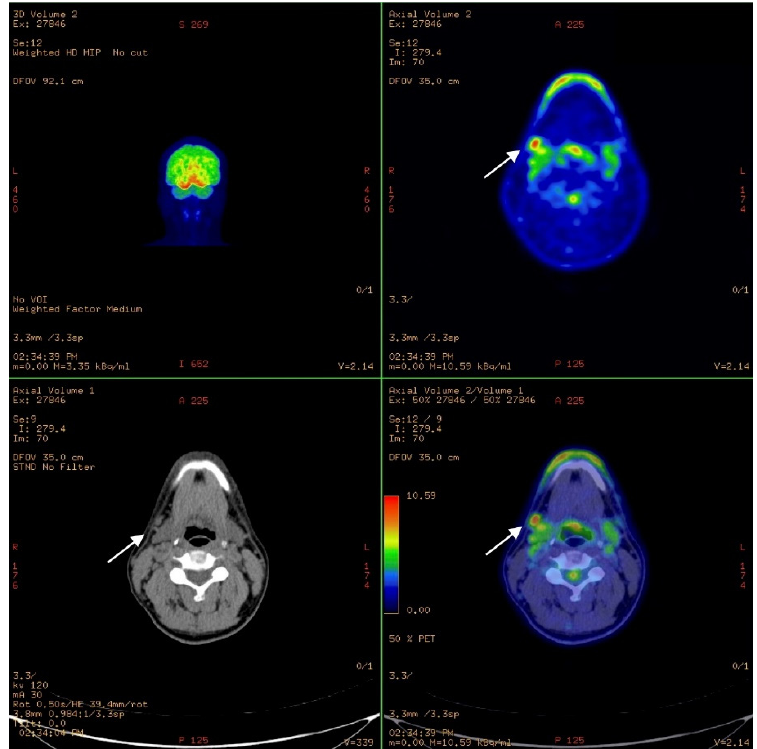
Figure 4. PET/CT (Positron emission tomography/Computed tomography) scan shows positive cervical lymph nodes at level IIa (white arrows).